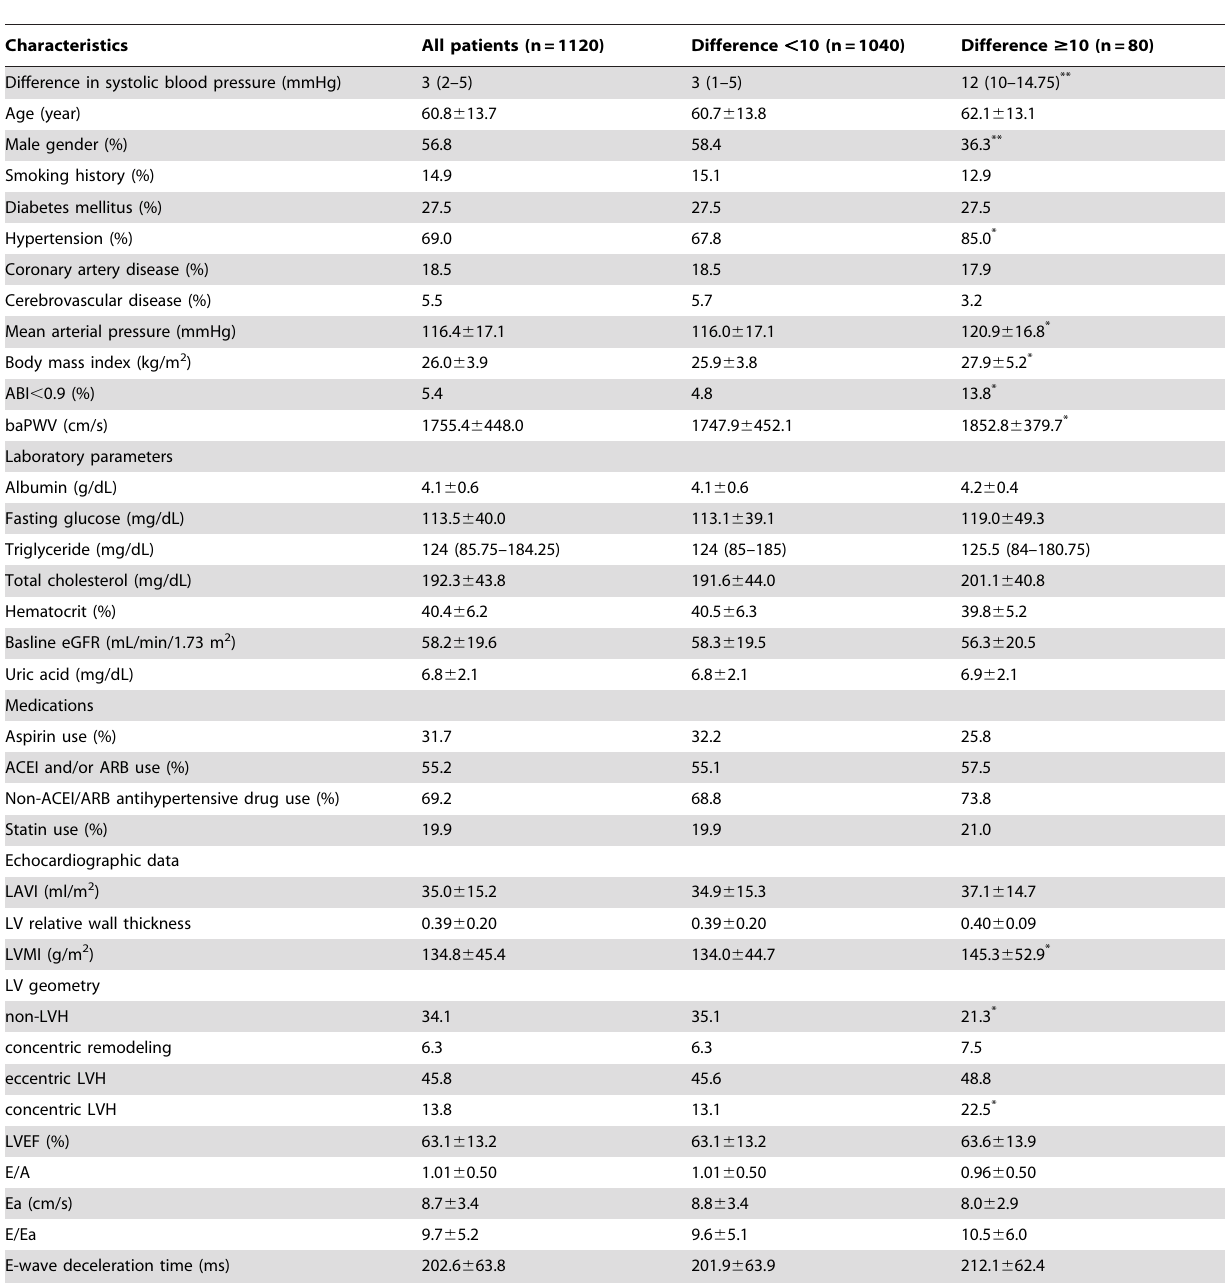
Table 1. Comparison of baseline characteristics between patients with and without difference in systolic blood pressure between arms of 10 mmHg or